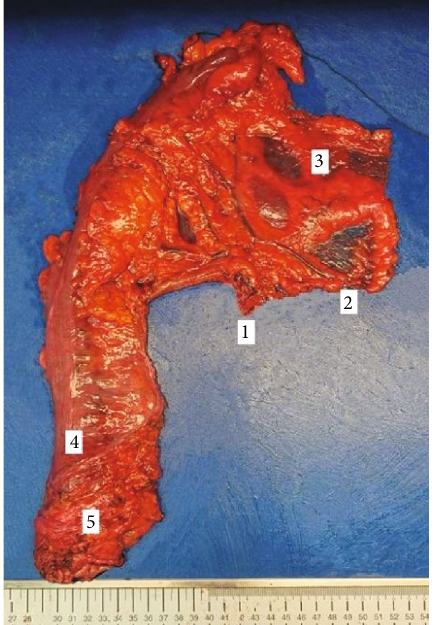
Figure 2: Resected gross specimen. 1: stump of the inferior mesenteric artery, 2: stump of the inferior mesenteric vein, 3: preserved peritoneal window, 4: level of the peritoneal re fl ection, and 5: